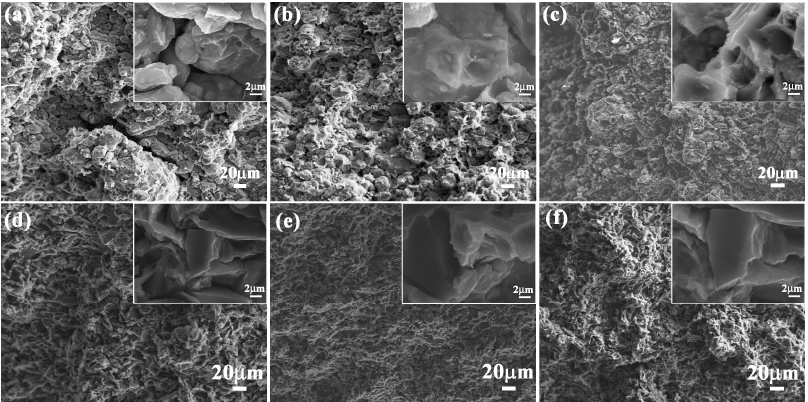
Figure 7. Flexural appearance of ( a ) Outer layer; ( b ) Middle layer and ( c ) Inner layer of bionic Meretrix lusoria shell composite material and ( d ) Outer layer; ( e ) Middle layer and ( f ) Inner layer of bionic Rapana venosa shell composite material.